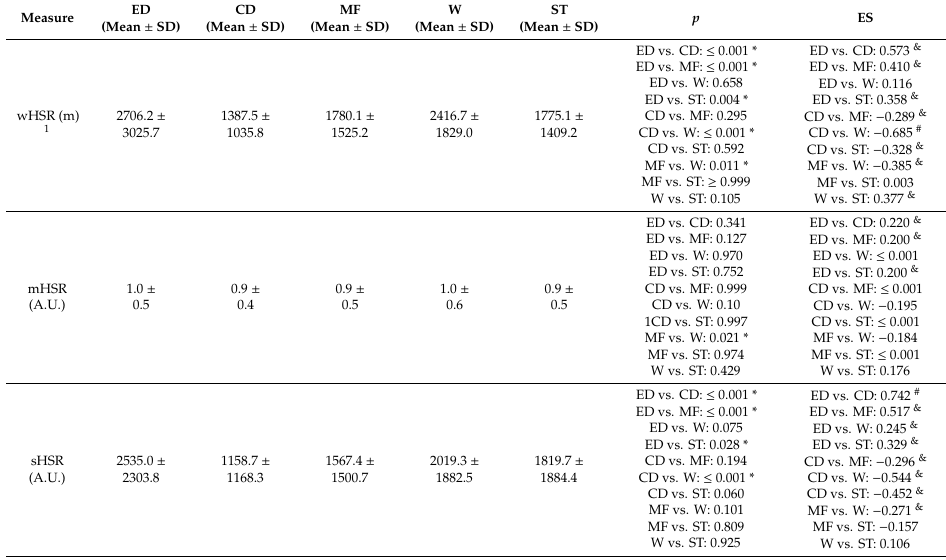
Table 3. Descriptive statistics (mean ± SD) of acute load, training monotony, and training strain for the high-speed running between playing